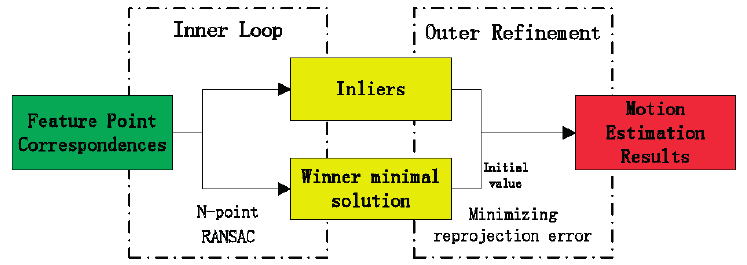
Figure 1. Motion estimation pipeline of two-frame feature based visual odometry